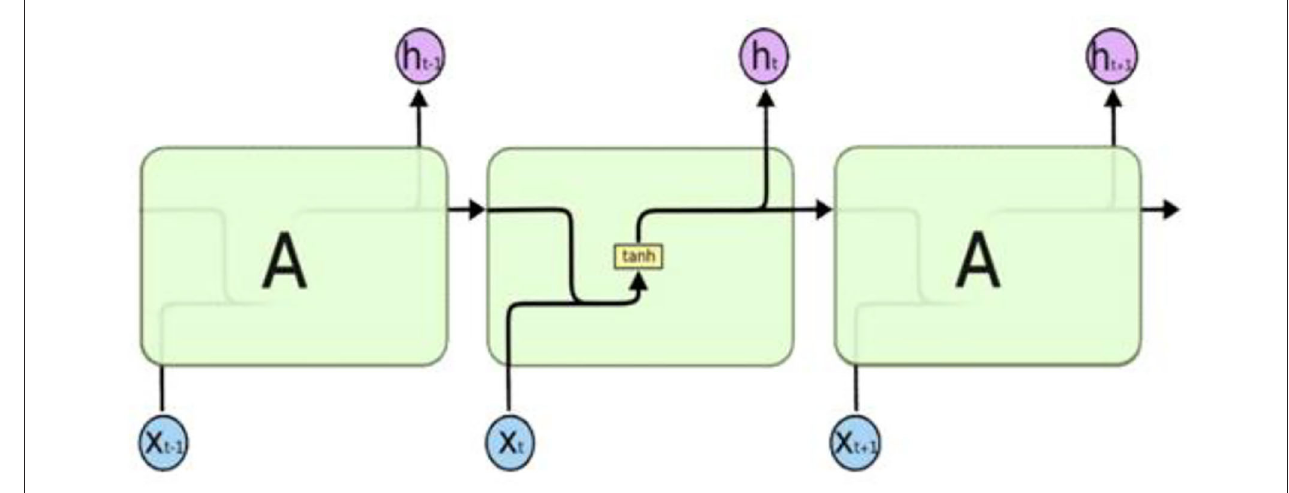
FIGURE 5 | Recurrent neural network structure.